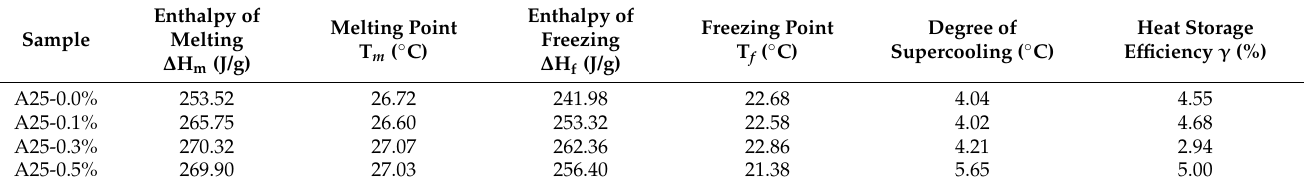
Figure 8. DSC thermogram of samples. Table 4. Melting and freezing point of